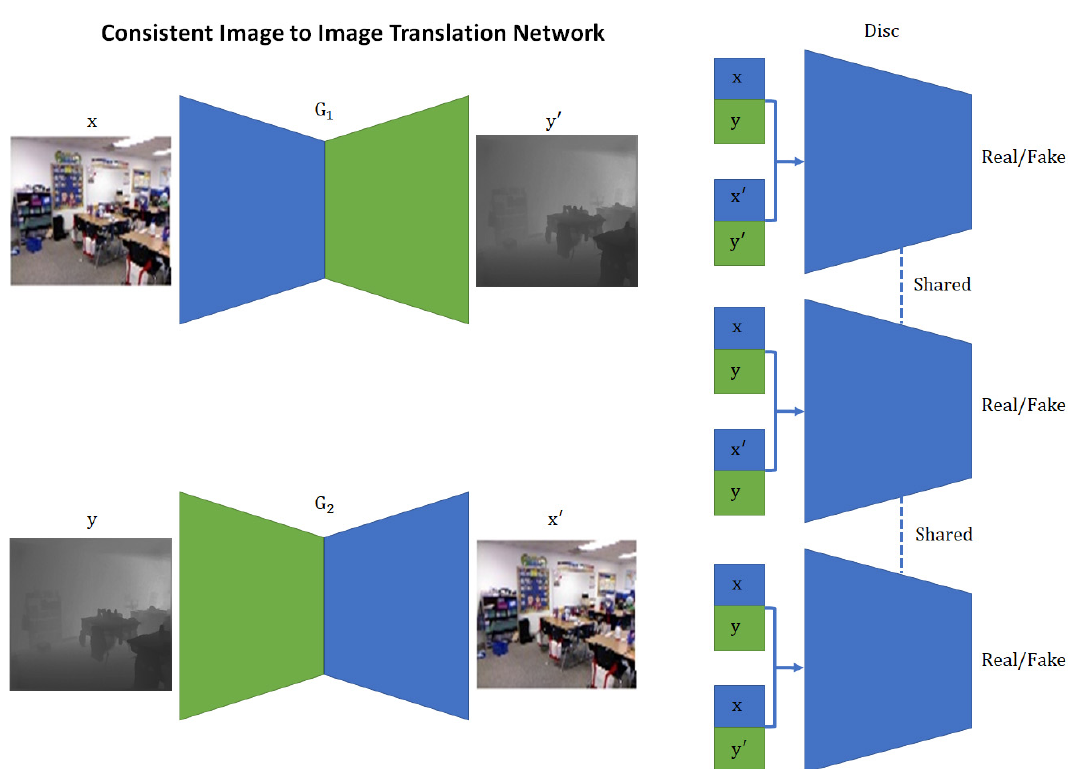
Figure 1. Consistent image-to-image translation network, where G 1 and G 2 are generators that translate images from domain x to domain y and from domain y to domain x , respectively. The discriminator takes the input in three different configurations, as shown on the right side of the